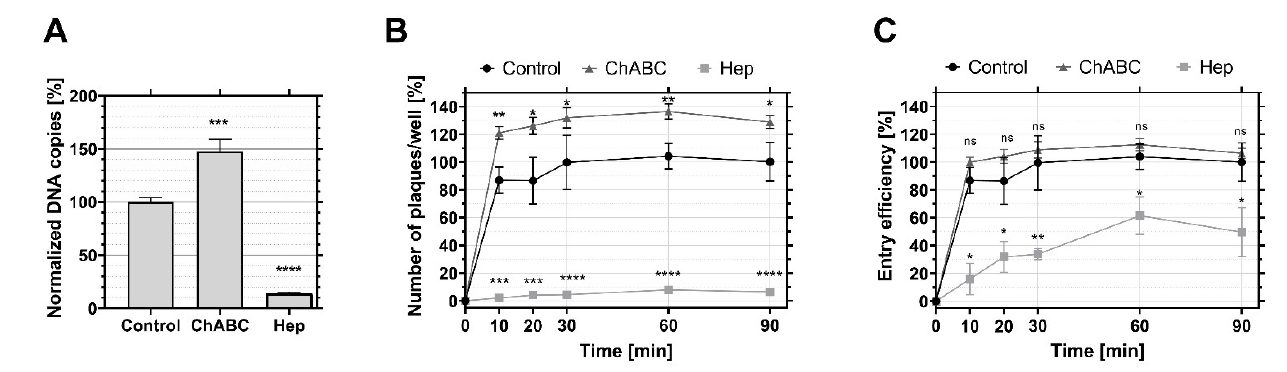
Figure 3. Binding and entry efficiency of HSV-1 in HaCaT cells. HSV-1 (KOS) binding and entry is recorded on wild-type HaCaT cells (Control), HaCaT cells treated with Chondroitinase ABC (ChABC) and HaCaT cells treated with heparinase I and III (Hep). ( A ) Number of virus particles bound to the surface of HaCaT cells after 1h incubation on ice. For quantification, the particles were detached by lysing the cell, and the genomic DNA quantified by qPCR. The data for the control group were normalized to 100. n = 12 for each condition. ( B ) Number of plaques formed over time reflecting the amount of virus internalized into the cells for the control (black circle), chondroitinase ABC-treated cells (ChABC, grey triangle) and heparinase-treated cells (Hep, light gray square). The data were normalized to the average control value at 90 min. ( C ) Entry efficiency defined as the number of viruses internalized into the cell (as measured in ( B )) divided by the number of virus particles bound to the cell surface (as measured in ( A) ). The data were normalized to the average of control value at 90 min. In ( B) and ( C) , each condition has 4 repeated measurements. A Student’s t - test was used to assess the significance, ns = not significant, * p ≤ 0.05, ** p ≤ 0.01, *** p ≤ 0.001 and **** p ≤ 0.0001 relative to the control HaCaT cells.